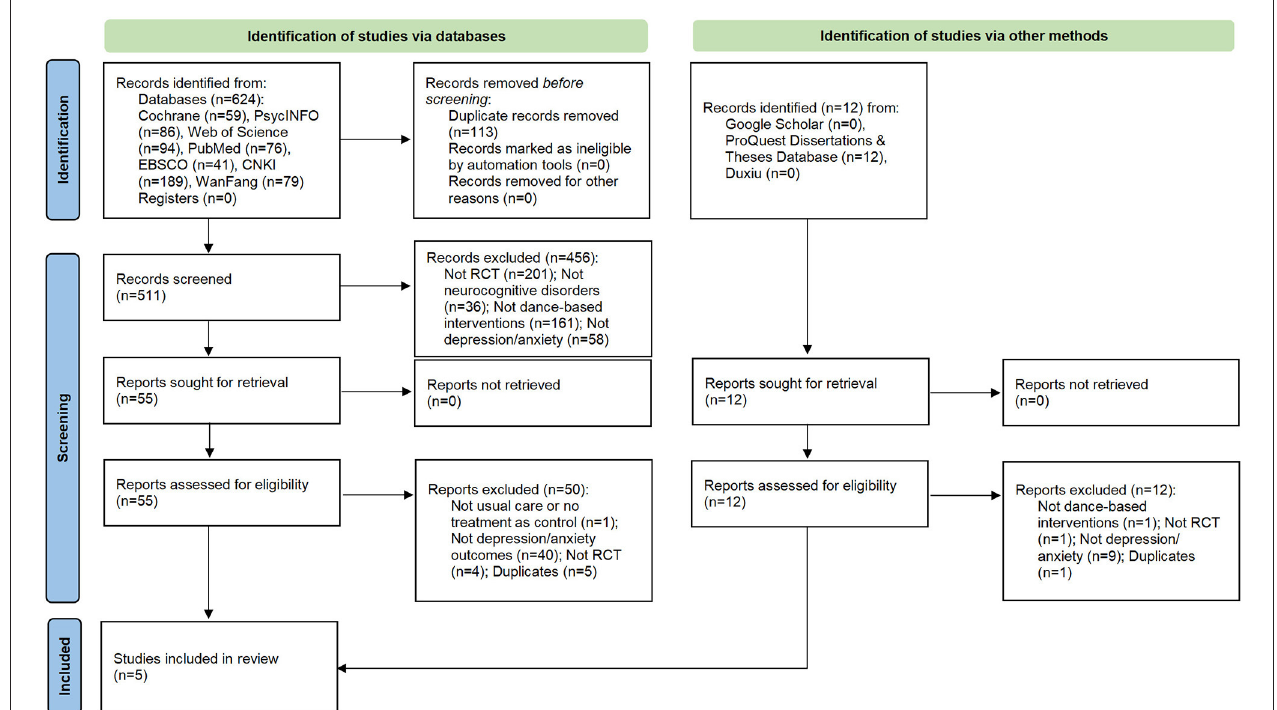
FIGURE 1 | Flowchart of the study selection